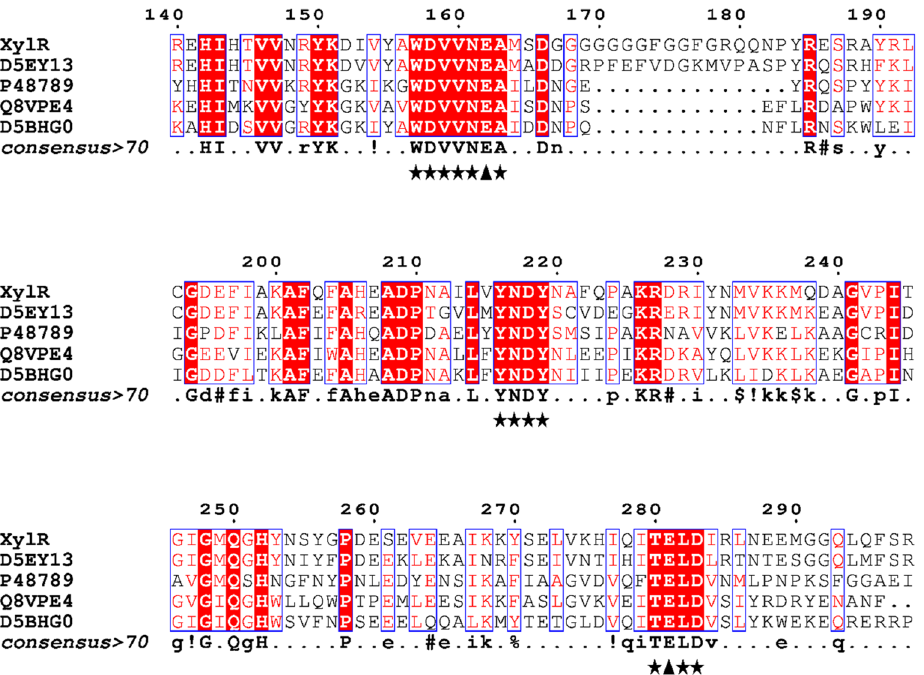
Figure 1. Fragment of the multiple alignment between the amino acid sequence of XylR and xylanases belonging to GH10. The conserved regions are marked with , and the conserved catalytic residues of glutamate (E) are highlighted with ▲ . The alignment included xylanase sequences from Prevotella ruminicola ★ (D5EY13), Prevotella ruminicola (P48789), Zunongwangia profunda (ADF53358) and a noncultivable bacterium (AAL06078). Similar amino acids are highlighted in red. Multiple alignment was performed using the Clustal Omega tool 16 , and assembly was performed in EsPript 3.0 17